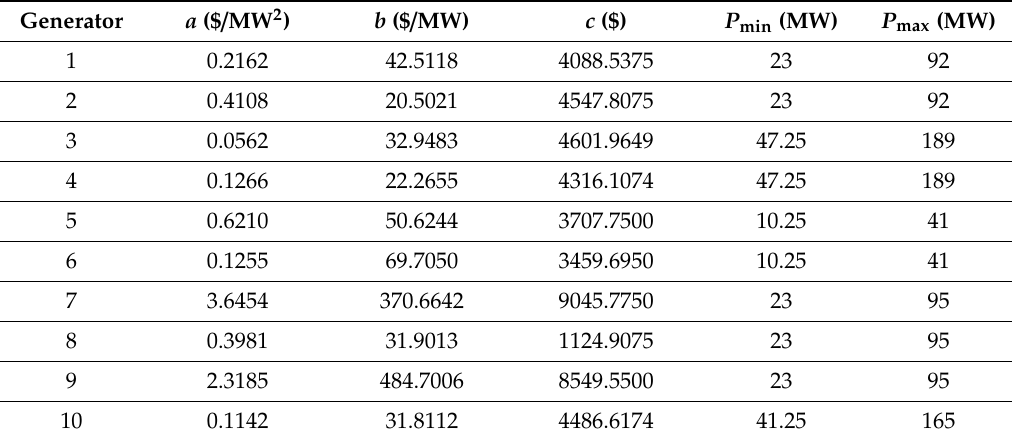
Table 21. A 10-unit thermal system cost coe ffi cients with lower and upper power